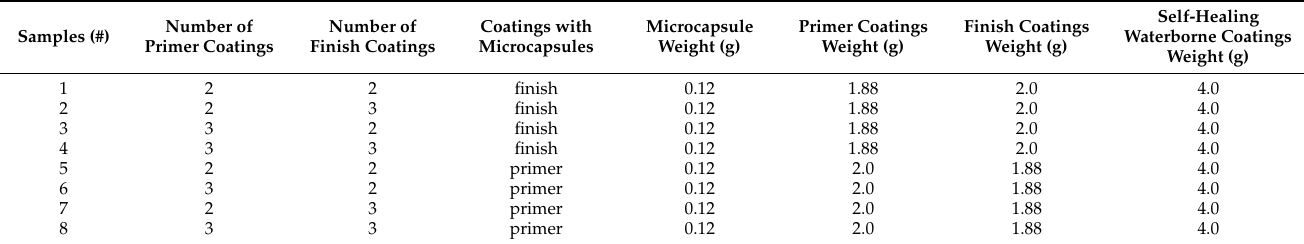
Table 1. Experimental schedule for optimizing coating processes and ingredients of microcapsules and waterborne coatings. Samples (#) Number of Primer